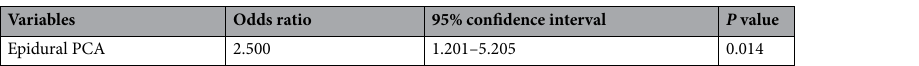
Table 7. Conditional logistic regression analysis of epidural PCA predicting packed red blood cell transfusion more than 3 units. PCA patient-controlled